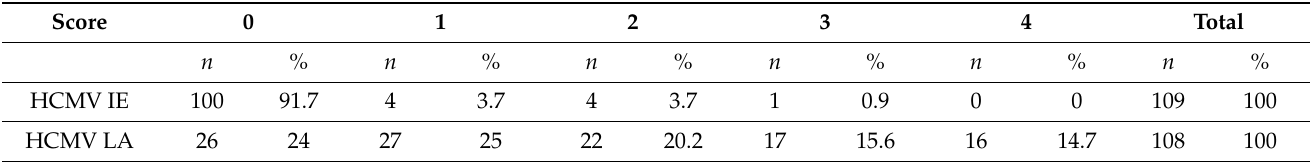
Table 2. Scores of immunohistochemical staining for HCMV IE and HCMV LA, in the breast cancer